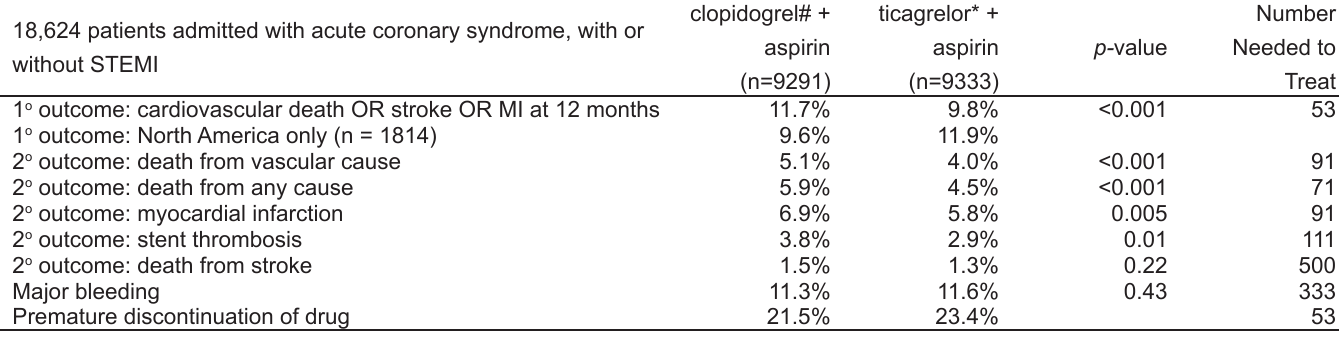
Table 3. Platelet Inhibition and Patient Outcomes. 18,624 patients admitted with acute coronary syndrome, with or